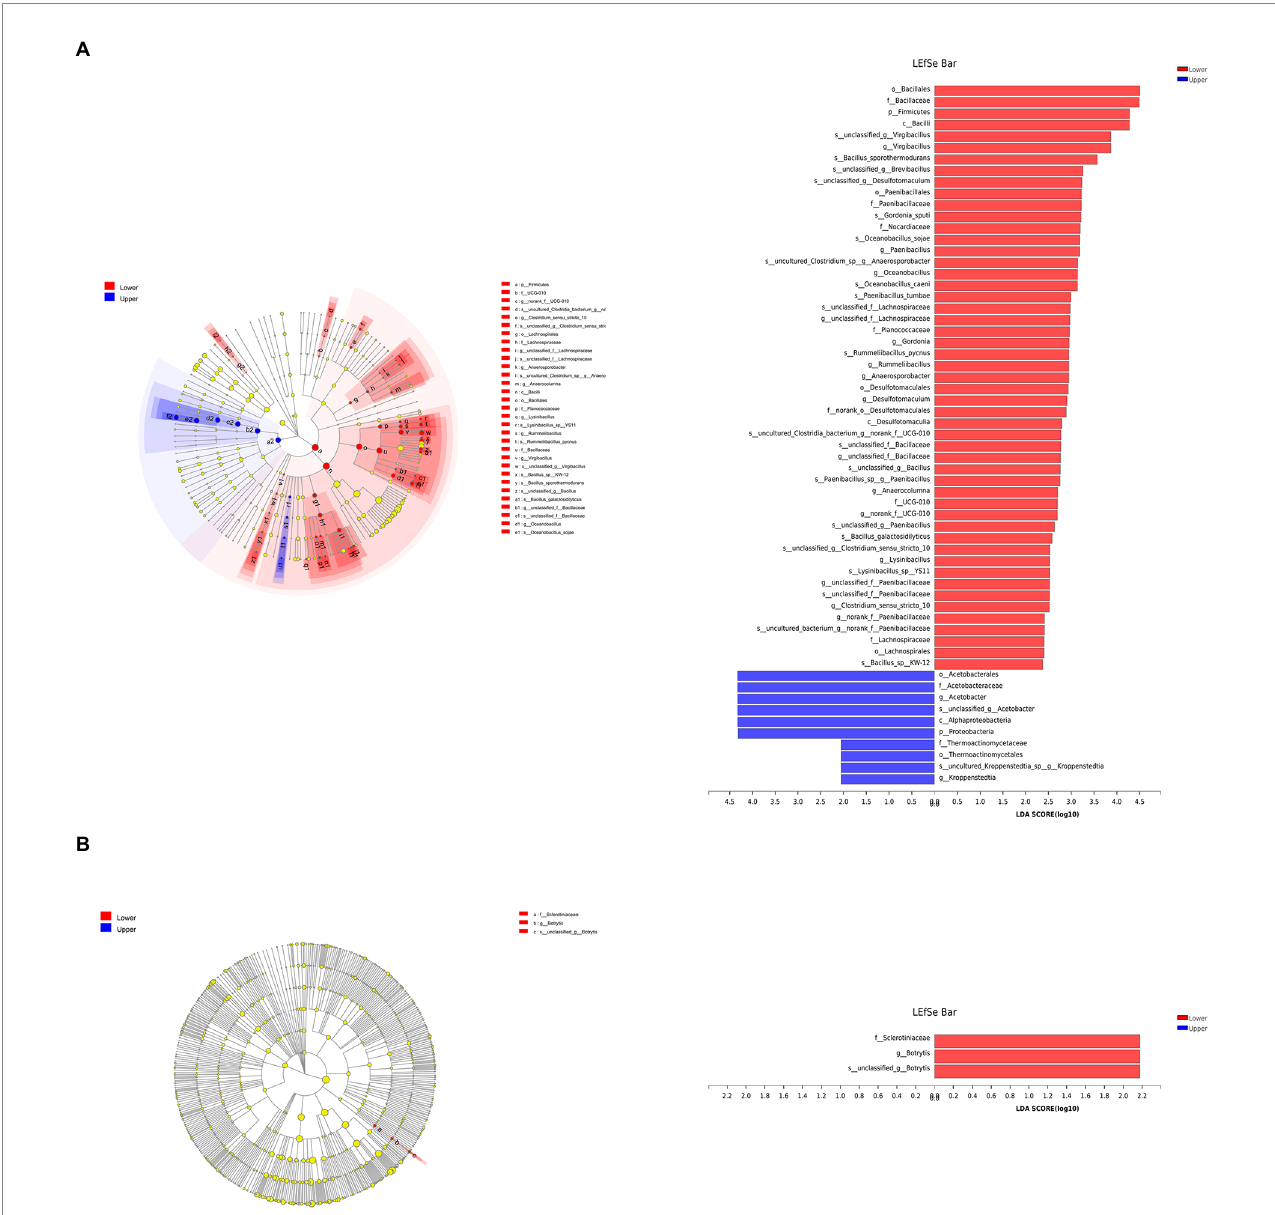
FIGURE 4 The bacterial (A) and fungal (B) communities of vinegar Pei were analyzed through Linear discriminant analysis effect size (LEfSe) to determine the optimal characteristic